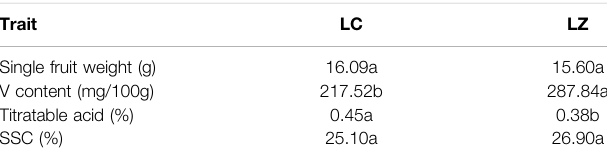
TABLE1| Fruittraits ’ investigation fromthe ‘ LingwuChangzao ’ jujube(LC)andits early-ripening mutant ‘ Lingzhou No.1 ’ (LZ) in 2019. Trait LC Single fruit weight